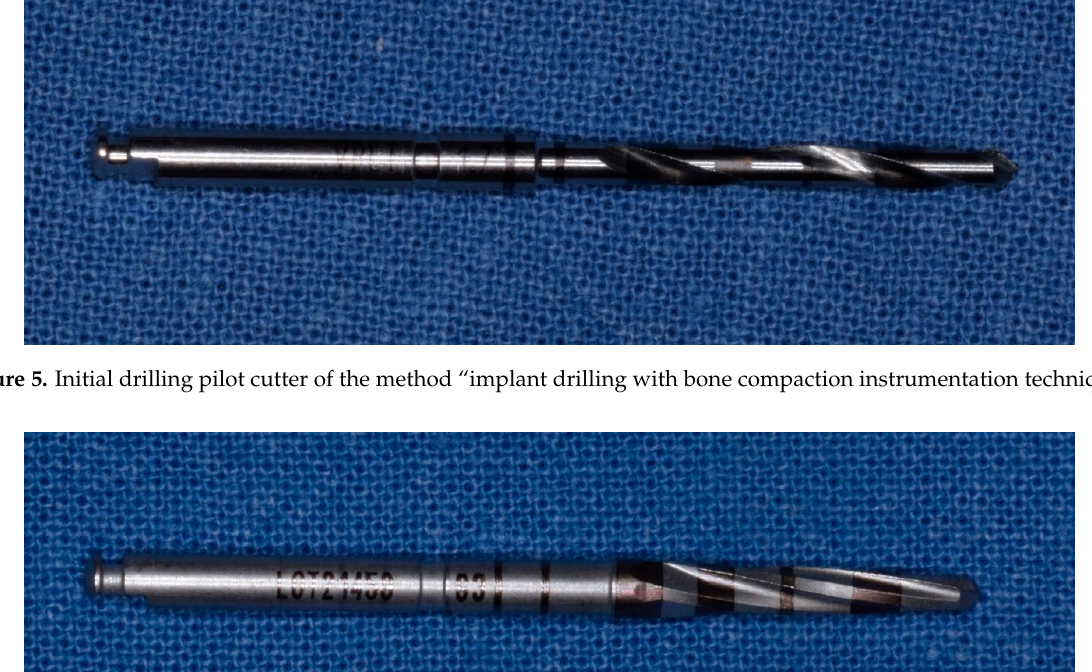
Figure 4. Details of the osseodensification drills system. ( A ) description of the cutters with an indication of the depth of the bone from 3.00 mm to 20 mm of the method “implant drilling with bone compaction instrumentation technique.” ( B ) Complete osseodensification Kit 13. “implant drilling with bone compaction instrumentation technique.” ( C ) Complete kit of all the cutters Versah ® (includes all the 13 cutters) with the method “implant drilling with bone compaction instru- mentation technique.” Autoclavable kit at 137 ◦ . ( D ) Cutters in progressive order of the method “implant drilling with bone compaction instrumentation technique.”